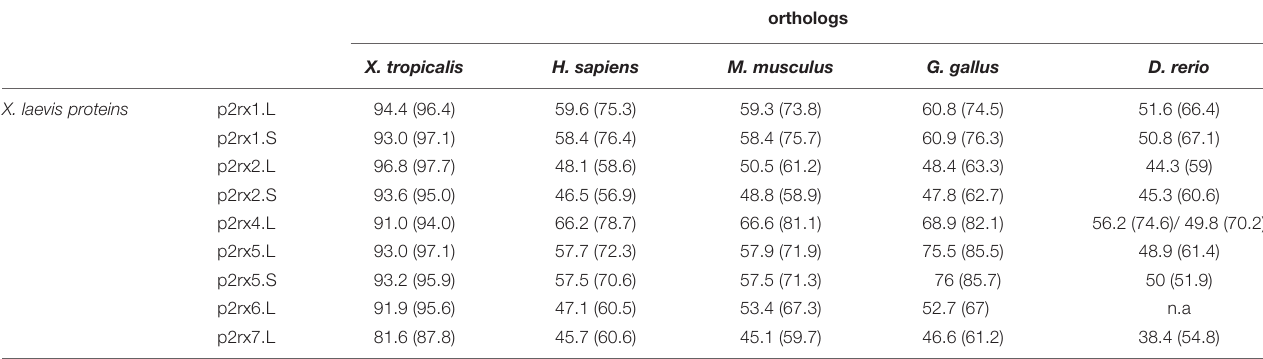
TABLE 1B | Relatedness between the X. laevis p2x receptor subunits and their vertebrate